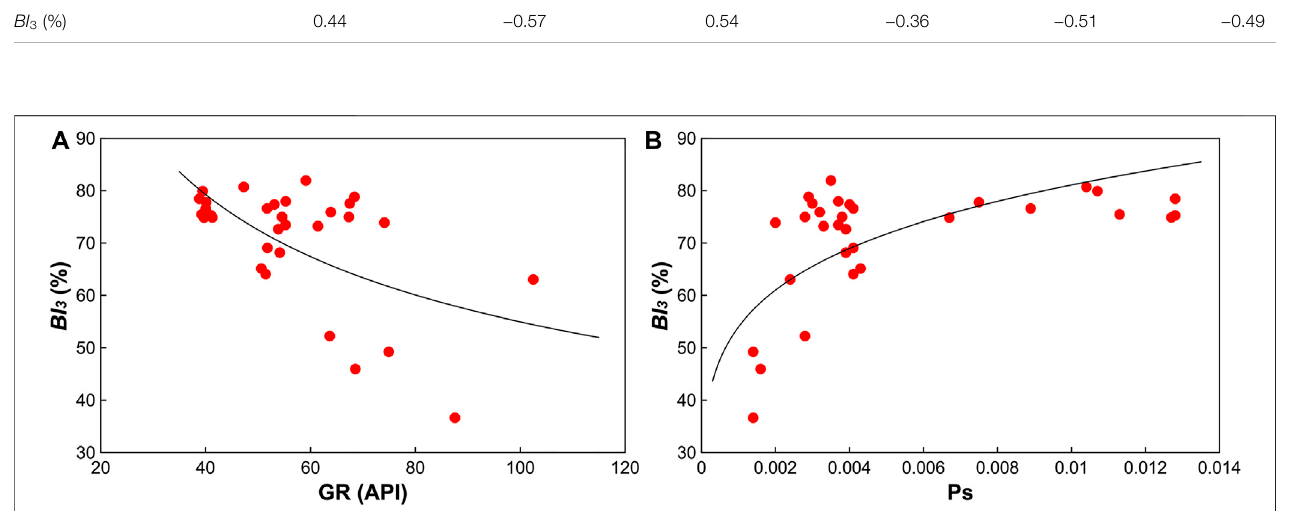
FIGURE 4 | Cross plots of BI 3 versus (A) gamma ray logging values and (B) brittleness index sensitive